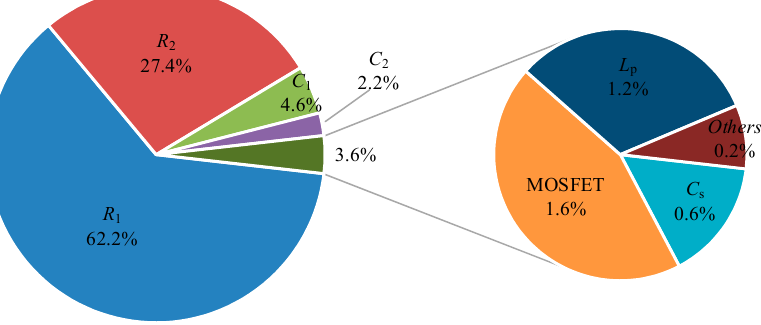
Figure 20. Percentage of the power losses caused by different components.